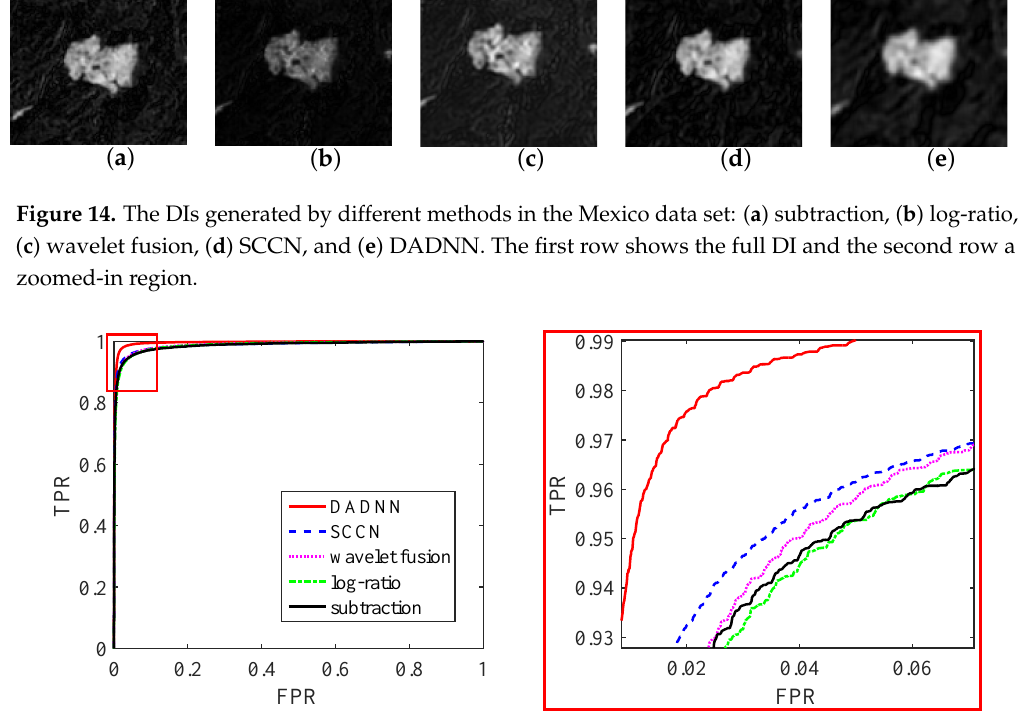
Figure 15. The receiver operating characteristics (ROC) plots of the five difference maps on the Mexico data set. The right shows corresponding enlarged areas of red boxes in the